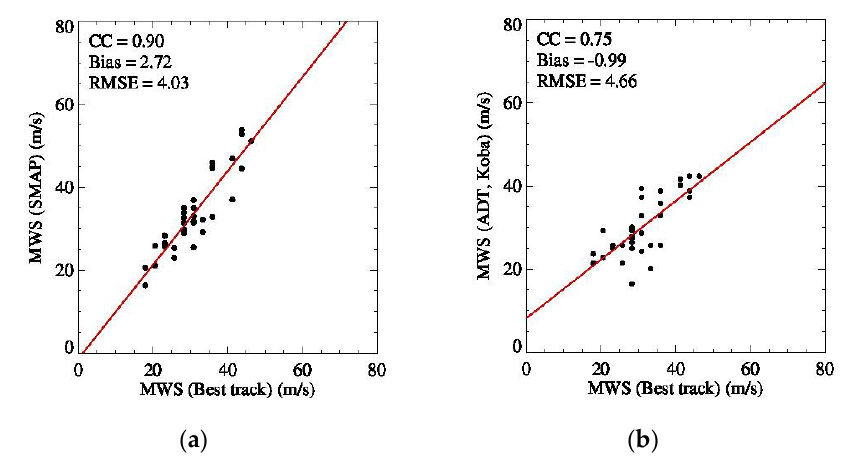
( a ) ( b ) Figure 6. ( a ) MWS (best track) vs. MWS (SMAP) and ( b ) MWS (best track) vs. MWS (Koba scale).